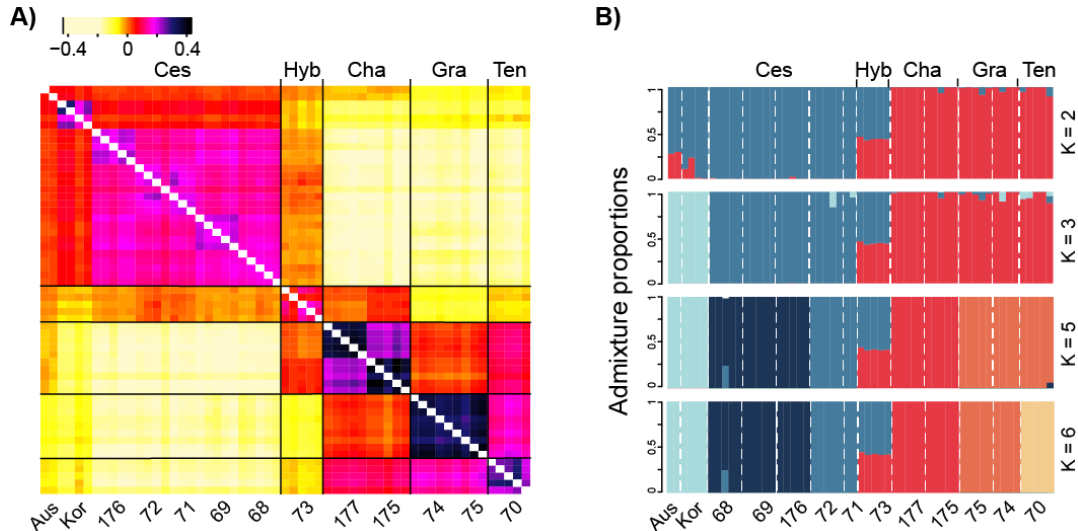
Figure 2. Clustering patterns of 57 accessions sampled across 13 sampling localities, based on 622,478 polymorphic sites filtered with ANGSD. ( A ) Heatmap obtained with covariance matrix results from PCAngsd. Population information is at the bottom and species names are on the top. Ces = D. cespitosa , Ten = D. tenella , Gra = D. gracillima , Cha = D. chapmanii . Hyb = Hybrid population, Aus = Australia population, Kor = Korea population. The diagonal estimation is excluded. ( B ) Genetic structure and admixture within Deschampsia in New Zealand and adjacent areas. Admixture diagrams are shown for K = 2, 3, 5, and 6. Ancestry proportions inferred with NGSadmix are shown as vertical bars where each vertical bar represents an individual. Species information is at the top of the figure. Population information is at the bottom. Species abbreviations are the same as in Heatmap.